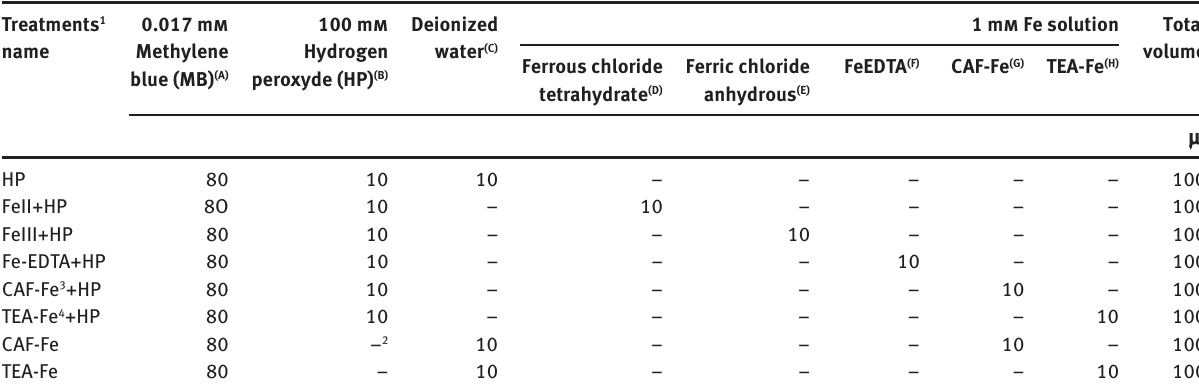
Table 1 Volume of each reagent used in the degradation